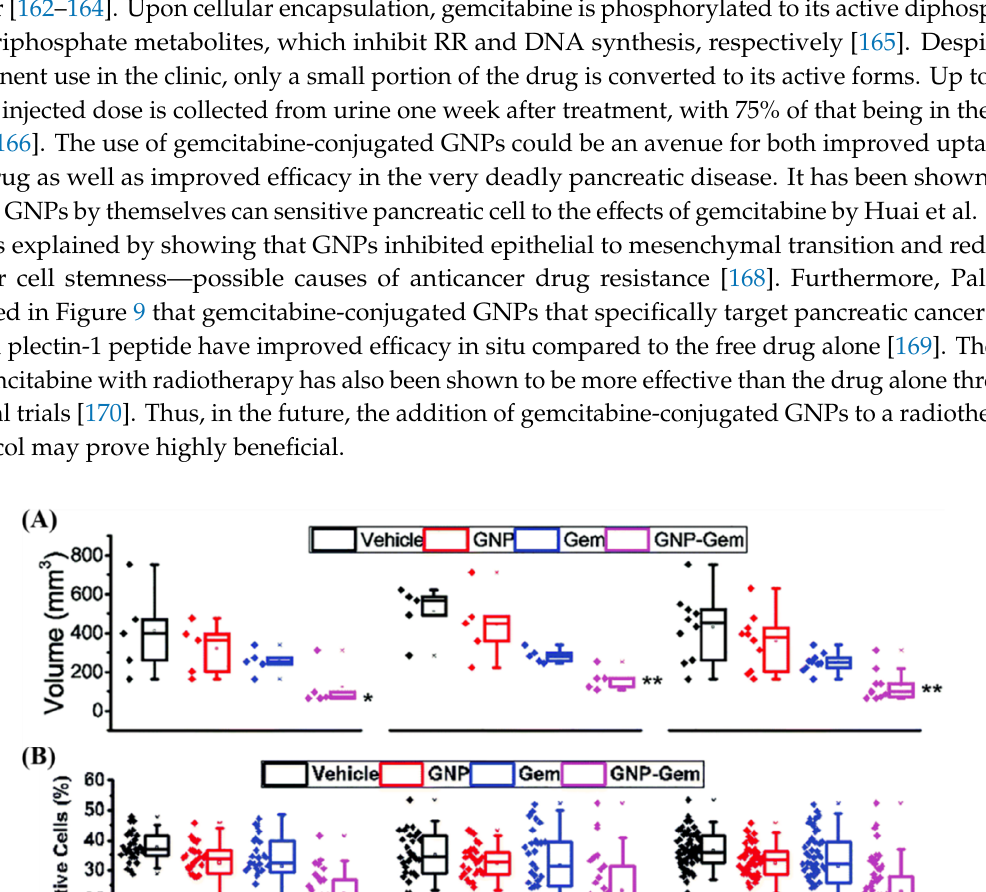
Table 1. Recent applications of anticancer drugs with gold nanoparticles in drug delivery and combined radiation therapy with clinically relevant energies. Treatment Experimental Cell Line/Tumor Modality Ref. Parameters Outcomes Model Ovarian Cancer Selective delivery of Cell Line 32.6 nm GNPs; Chemotherapy nanoparticles to tumor (A2780); B16/F10 [133] 2.5 mg/kg dose and improved efficacy tumor-bearing C57BL/6 mice DOX-PEG- GNPs 41 nm GNPs; 6 mg/kg dose